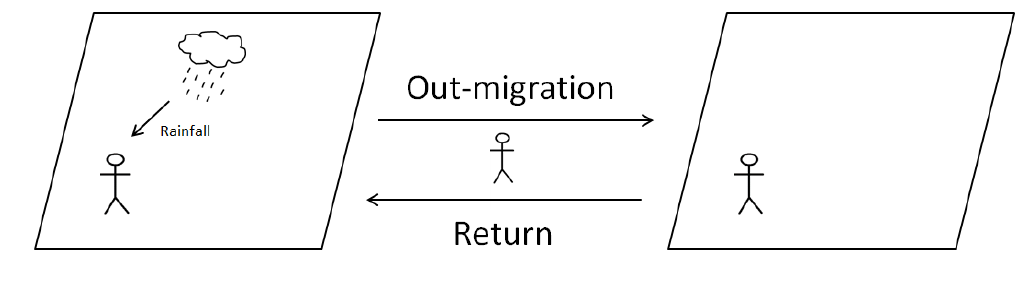
Fig. A1.5 Diagram drafted for the ABM described by Kniveton et al. (2011; 2012); the destination system is also influenced by rainfall, but as the return decision is not influenced by rainfall it is not depicted visually in the destination system